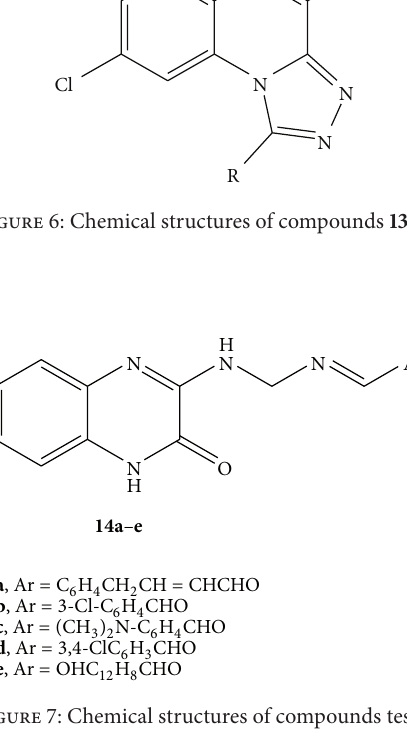
Figure 9: Chemical structures of compounds tested 16a – i